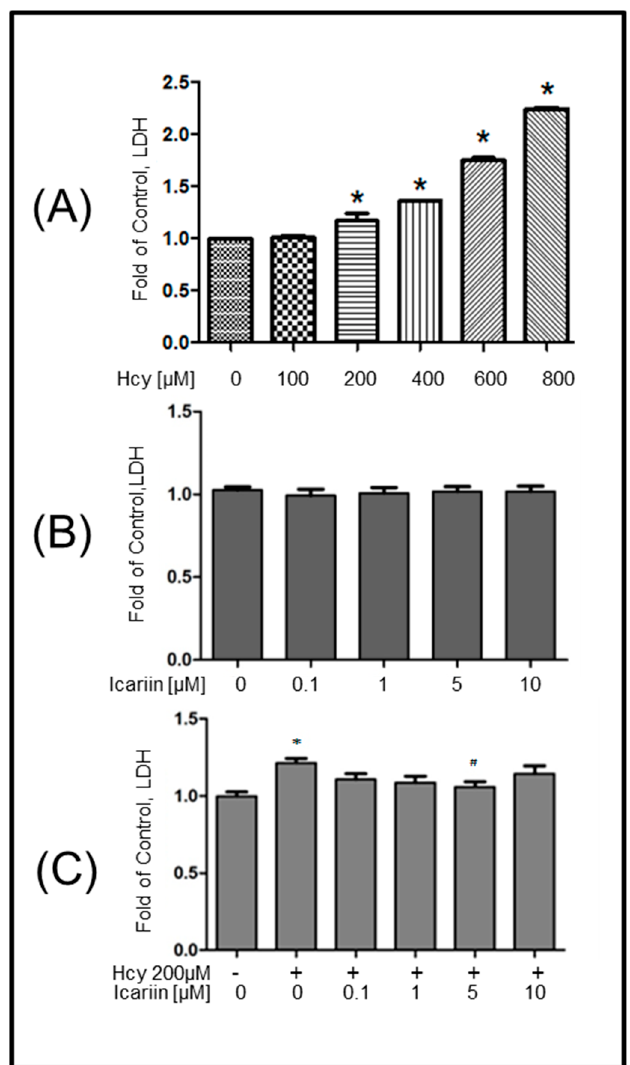
Figure 2. Cytotoxicity of Hcy and icariin measured by LDH assay. Cortical neurons were treated with Hcy ( A ), Icariin ( B ) and Hcy plus icariin ( C ) and performed LDH assay. The treatment duration for Hcy or Icariin was 12 h. In the co-treatment, cells were pretreated 1 h before the addition of Hcy. Results were quantified and expressed as fold of control. Data represents mean ± SE from at least three independent experiments. The significance of differences among treatment groups was determined by one-way ANOVA. *: p < 0.05 compared to control. “#”: p < 0.05. “+” and “-”: with and without the compound.